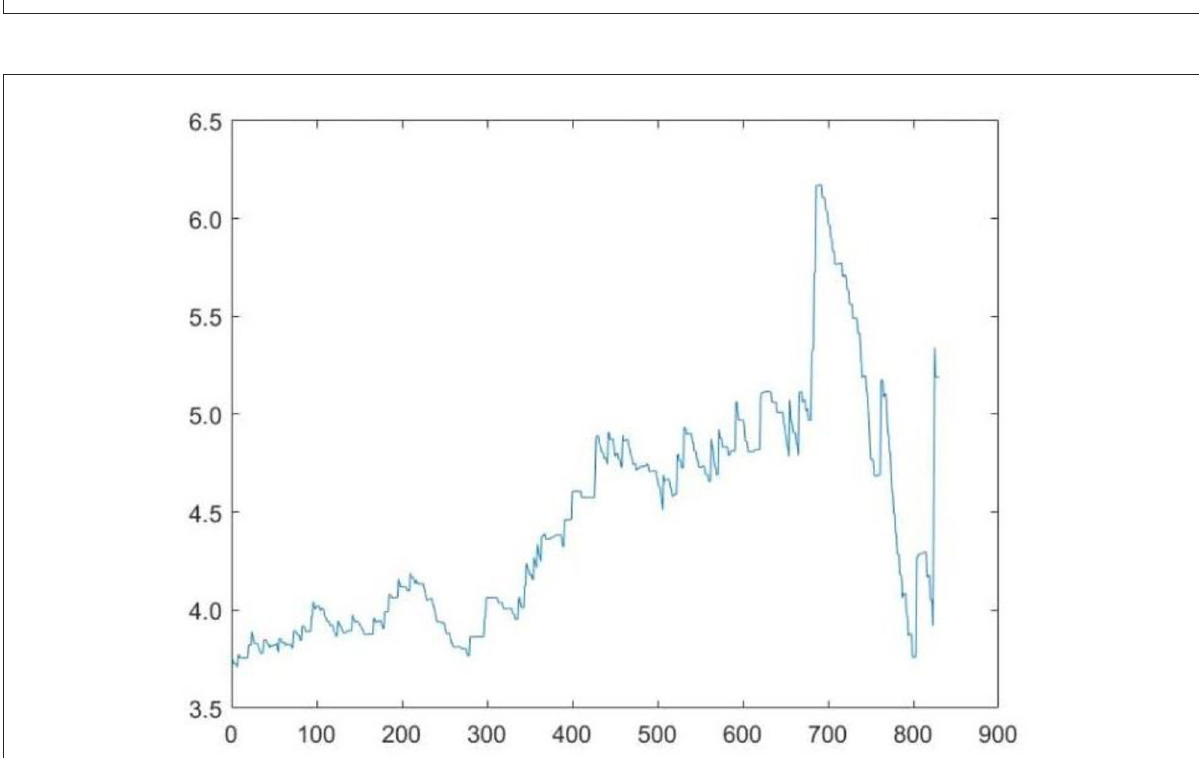
FIGURE3 A dynamic diagram of the population parameters